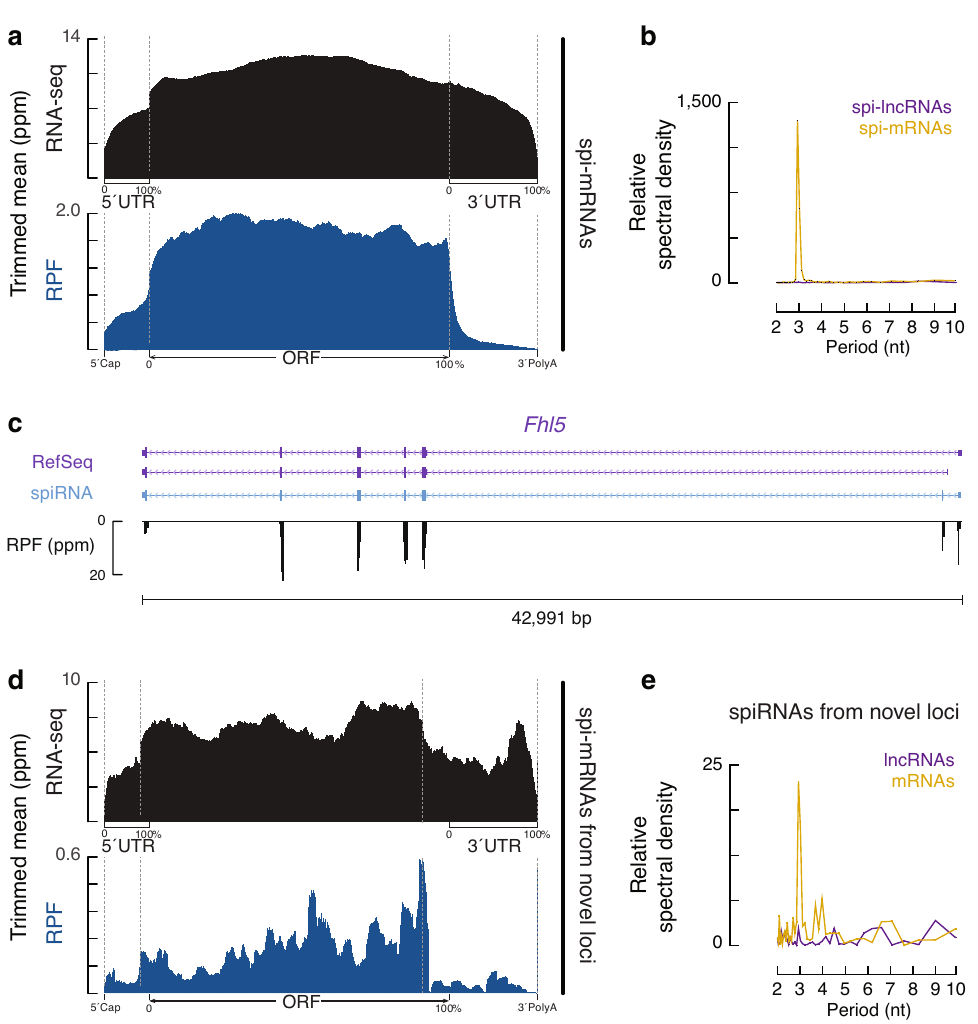
Fig. 3 spiRNAs include both mRNAs and lncRNAs. a Aggregated data for RNA-seq signal distribution ( top ) and ribosome occupancy ( bottom ) on 2,343 spi-mRNAs (10% trimmed mean). Signals are aligned to the transcriptional start site (5 ′ cap) and site of polyadenylation (3 ′ PolyA). Signals are further aligned to the ORF regions. RPFs (ribosome protected fragments) across 26 – 32 nt were used to detect ribosome occupancy. The x -axis represents the median length of 5 ′ UTRs, ORFs and 3 ′ UTRs. Ppm, parts per million. b Discrete Fourier transformation of the distance spectrum of 5 ′ -ends of RPFs across 2,343 spi-mRNA coding regions (gold) and 1097 spi-lncRNAs (purple) to show nucleotide periodicity. c A spiRNA example of novel transcript structures with altered coding regions in comparison to RefSeq annotation. From top to bottom, RefSeq, spiRNA, and RPF (ribosome protected fragment) reads. Ppm, parts per million. d Aggregated data for RNA-seq signal distribution ( top ) and ribosome occupancy ( bottom ) on 78 novel spi-mRNAs from intergenic loci (10% trimmed mean). e Discrete Fourier transformation of the distance spectrum of 5 ′ -ends of RPFs across coding regions of 78 novel spi-mRNA (gold) and across 120 novel spi-lncRNAs (purple) from intergenic loci to show nucleotide periodicity. Source data of Figs. 3b, 3e are provided as a Source Data fi